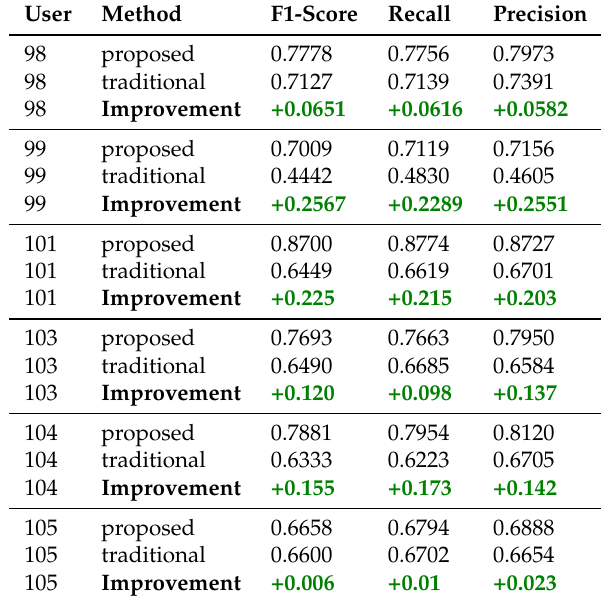
Table 5. The average classification performance of all models for each